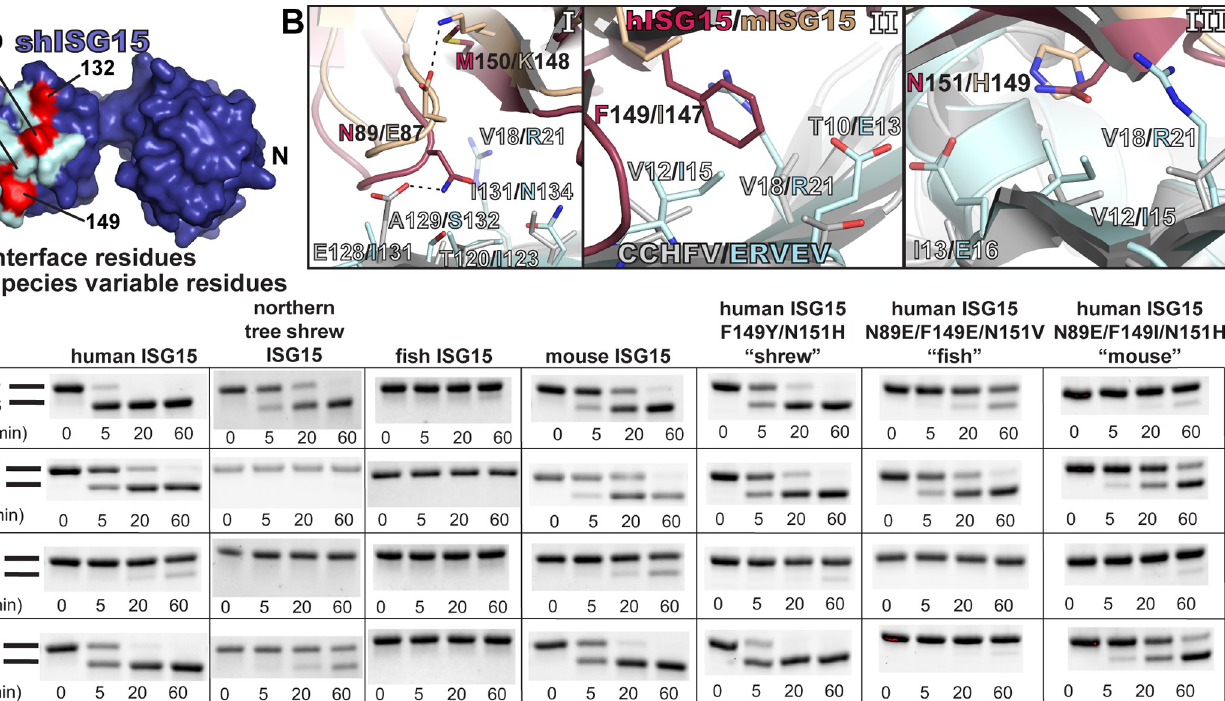
PLOS ONE | https://doi.org/10.1371/journal.pone.0226415 December23,